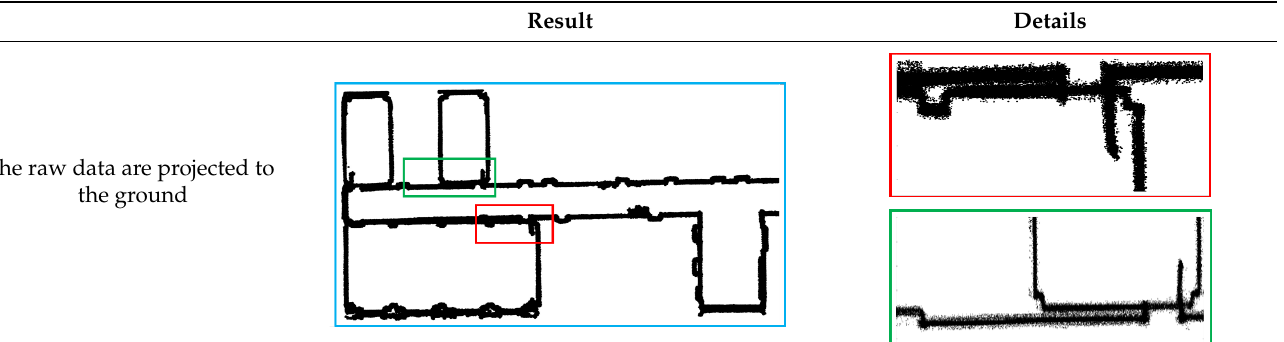
the raw data are projected to the ground